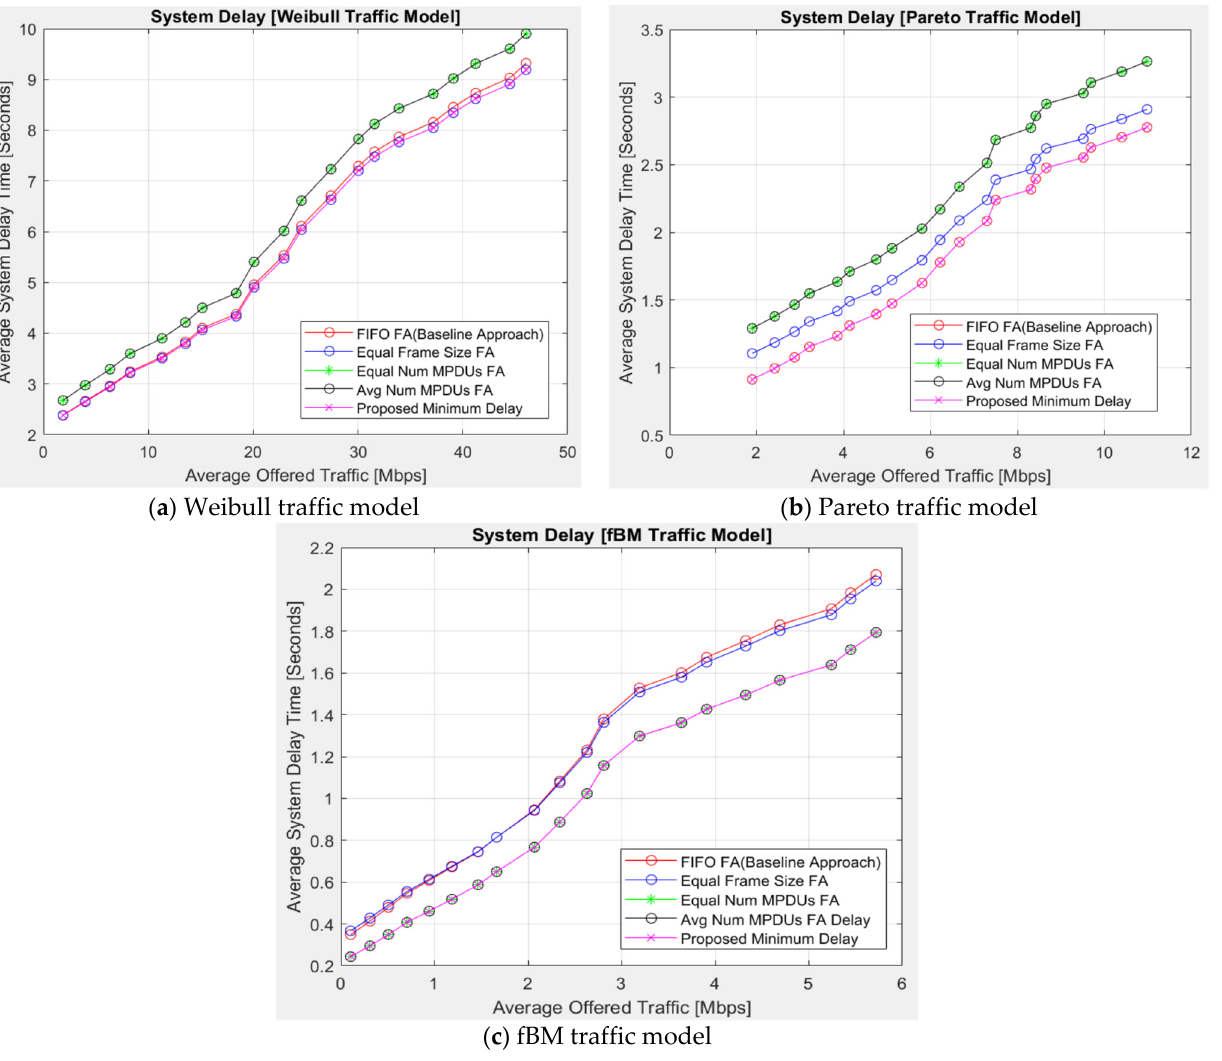
Figure 2. Performance of average system delay time under the effects of heterogenous traffic models when SNR = 8 dB and Num STA = 4.